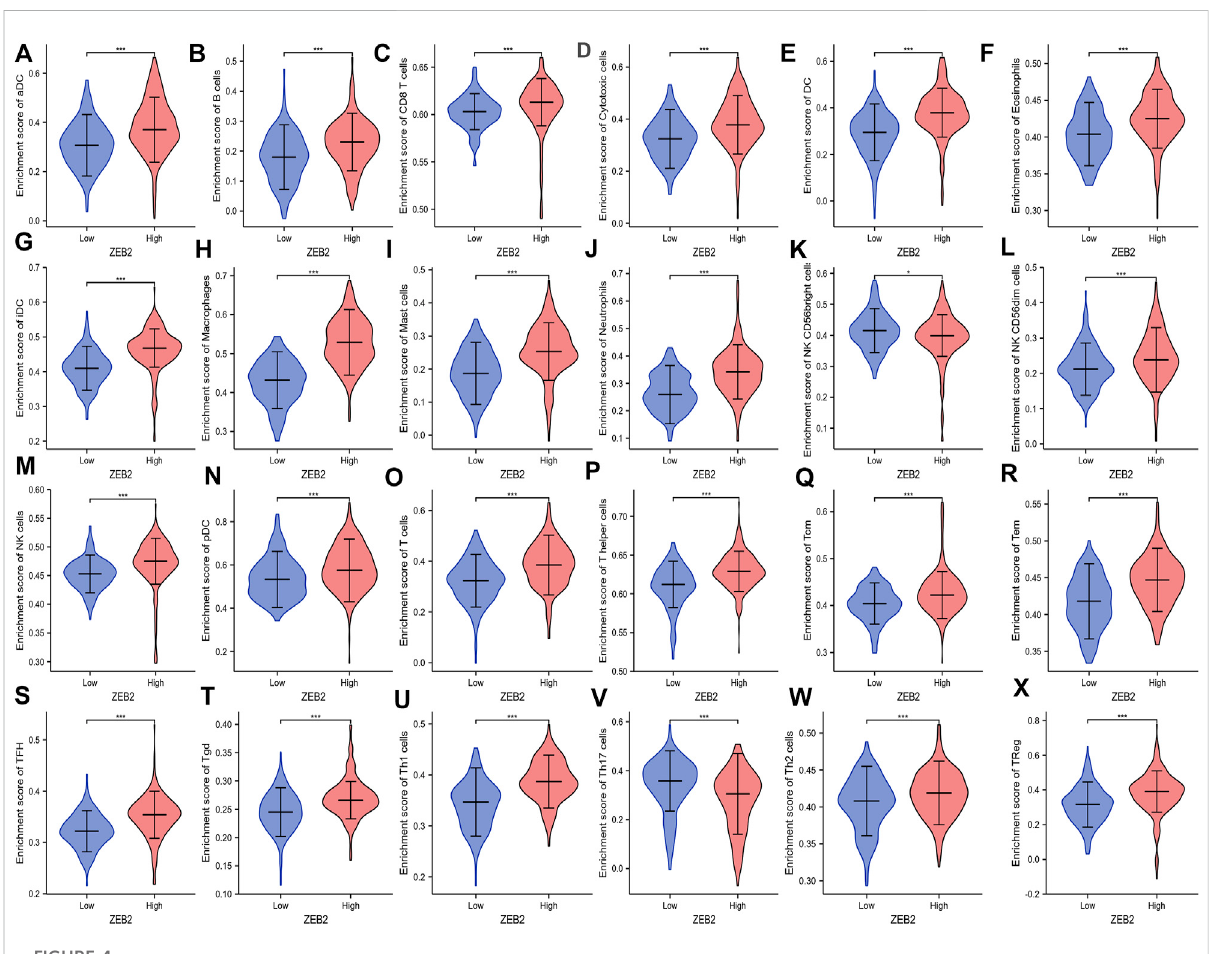
FIGURE 4 (A – X) Enrichment of 24 types of immune cells in the ZEB2 high- and low-expression